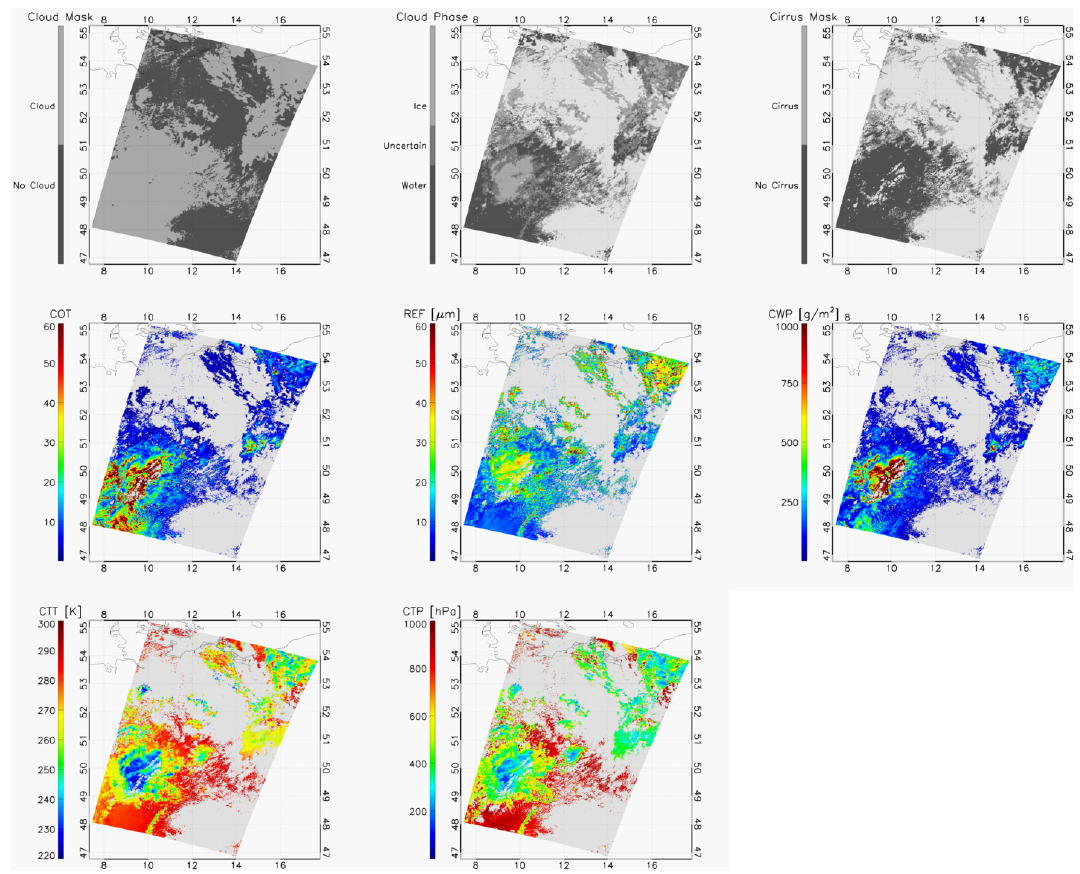
Figure 3. Example of the FAME-C cloud mask; cloud phase mask; cirrus mask; and retrieved cloud optical, microphysical and macrophysical properties for a synergy AATSR–MERIS orbit segment above Germany on 21 July